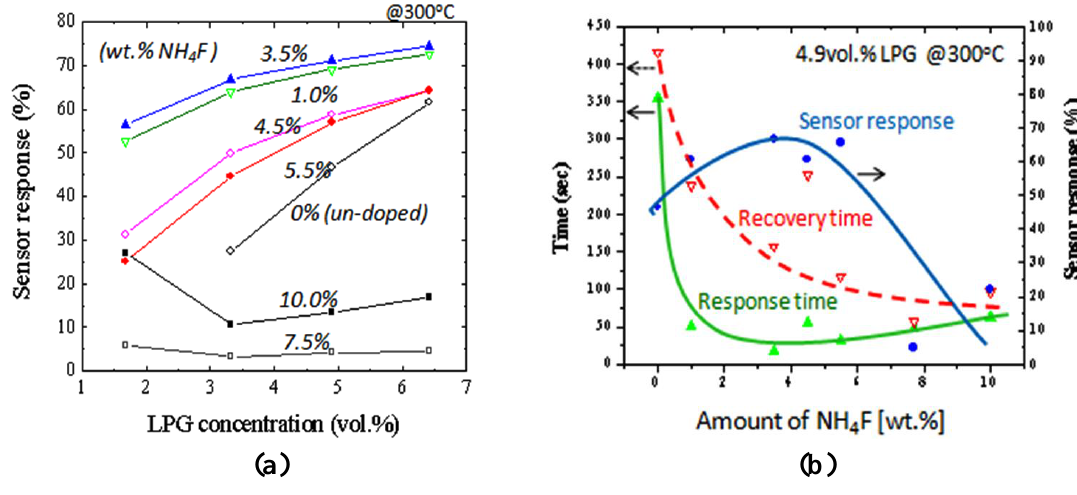
Figure 8. Sensing characteristics at 300 °C of the SnO of NH F. (a) Sensor response vs. LPG concentration. (b) Sensor response time, recovery 4 time and sensor response to 4.9 vol.%